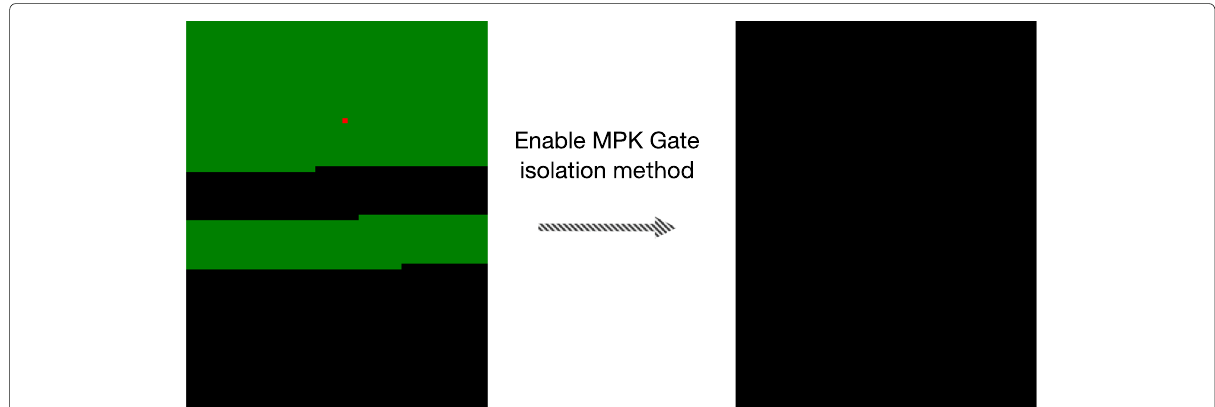
Fig. 8 The memory layout for kernel page pool from the view of application. Green for accessible area. Black for unaccessible or invalid area. Red for the pages containing secret